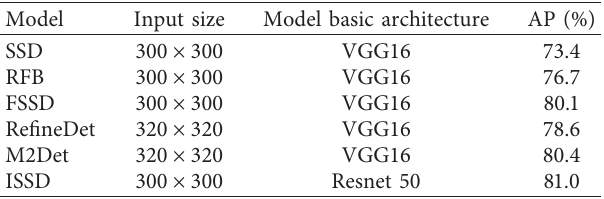
urchin detection algorithm based on feature enhancement.